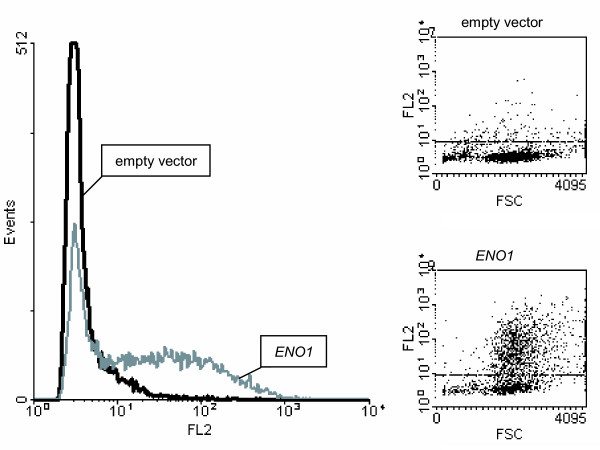
FACS results of SK-N-AS cells two days after transfection of empty pIRES-EGFP-vector (black line) and ENO1-pIRES-EGFP (grey line). The cells were TUNEL stained using TMR-red labelled nucleotides to label all apoptotic cells red. There is a clear increase of the number of red cells (FL2) in ENO1 transfected cells compared to empty vector control.